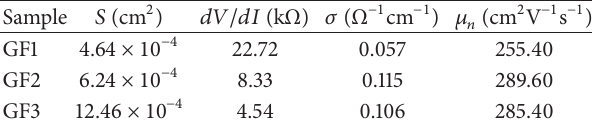
Table 2: Transport parameters from graphite